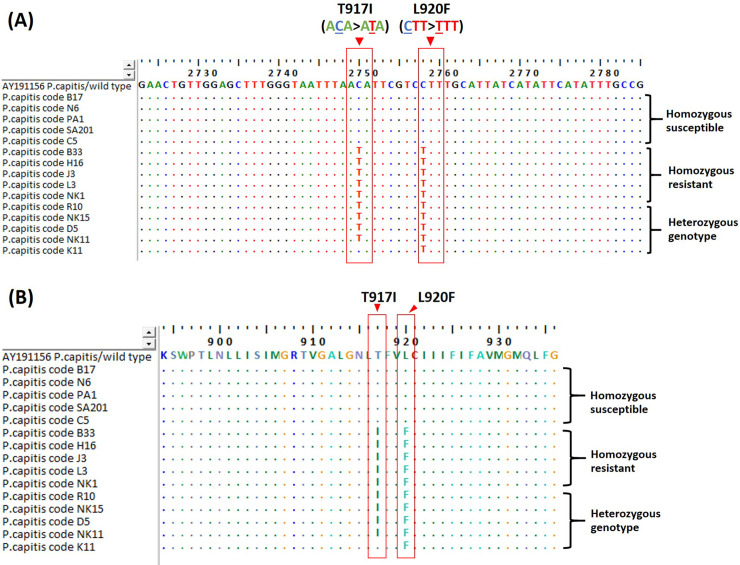
An alignment of nucleotide sequences (A) and amino acid sequences (B) of the α subunit of VSSC gene of human head lice collected from Thailand. The sequence showed the position of the kdr T917I mutation as well as the position of L920F mutation indicated by a vertical column.